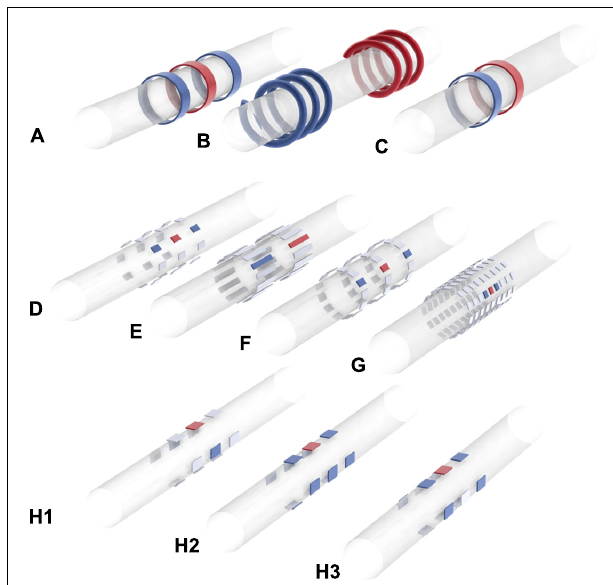
FIGURE 3 | Electrode array geometries and stimulation patterns used in major sVNS studies. (A) Yoo et al. (2016). (B) Ordelman et al. (2013), Patel and Butera (2015), Tosato et al. (2007). (C) Pelot and Grill (2020), Patel et al. (2017), Dali et al. (2019). (D) Plachta et al. (2013, 2014, 2016), Gierthmuehlen and Plachta (2016). (E) Aristovich et al. (2021). (F) Peclin and Rozman (2009). (G) Peˇclin and Rozman (2014). (H) Dali et al. (2018) [ H1 : transverse tripolar (TT), H2 : transverse tripolar ring (TTR), H3 : tripolar longitudinal ring (TLR)]. Blue = anode, red = cathode, gray = unused. Researchers have used a range of different electrode array geometries for sVNS. Some have used rings or helical electrodes; recently there is a move toward smaller rectangular contacts that can be placed at different positions around the nerve circumference. These contacts are often arranged to allow for bipolar or tripolar